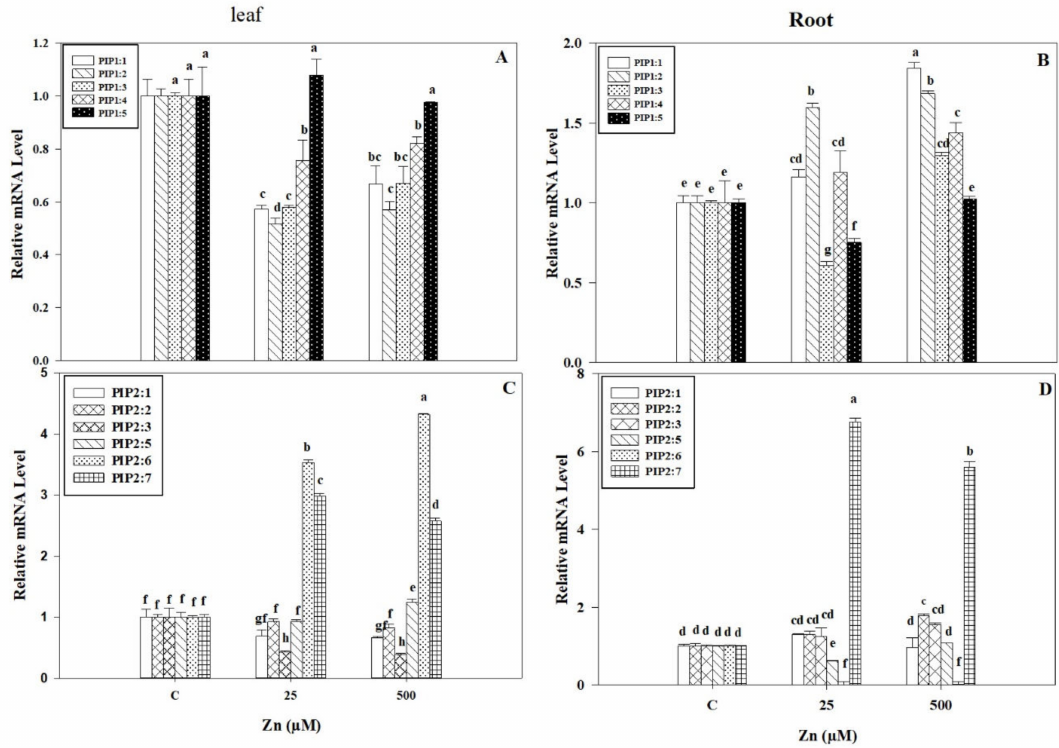
Figure 6. Relative expression level of aquaporin isoforms after long-term application of Zn: ( A ) leaf PIP1, ( B ) leaf PIP2 ( C )root PIP1 ( D )root PIP2 genes, determined by Q-RT-PCR in control plants and plants treated with 25 or 500 µ M Zn. Mean values and standard errors are shown ( n = 3). Bars with di ff erent letters represent significant ( p < 0.05) di ff erences after ANOVA and an LSD (Least significant di ff erence)